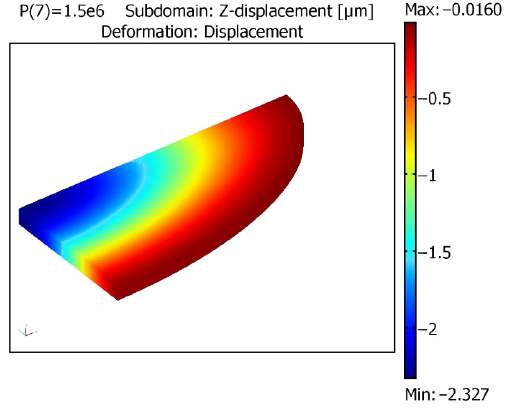
Figure 18. A quarter of the elliptical diaphragm displacement in design 3 using FEA.